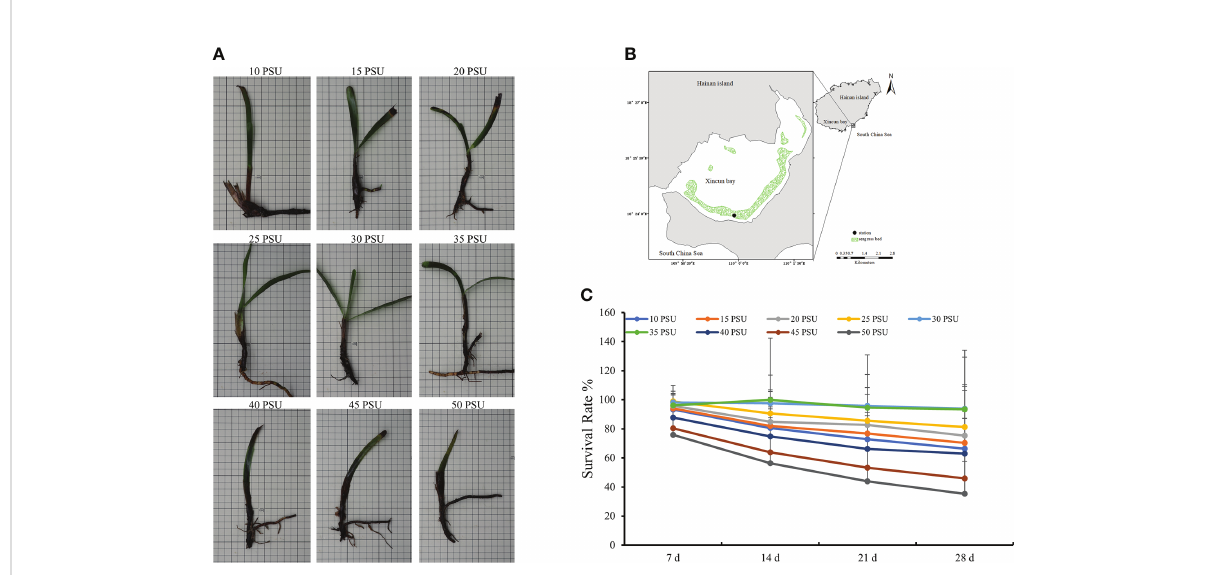
FIGURE 1 The growth state and survival rate of T. hemprichii under different salinity conditions. (A) Growth state; (B) Location of sampling site, Xincun Bay, South China Sea; (C) Survival Rate. The statistical signi fi cance was assessed using a one-way analysis of variance (ANOVA), P